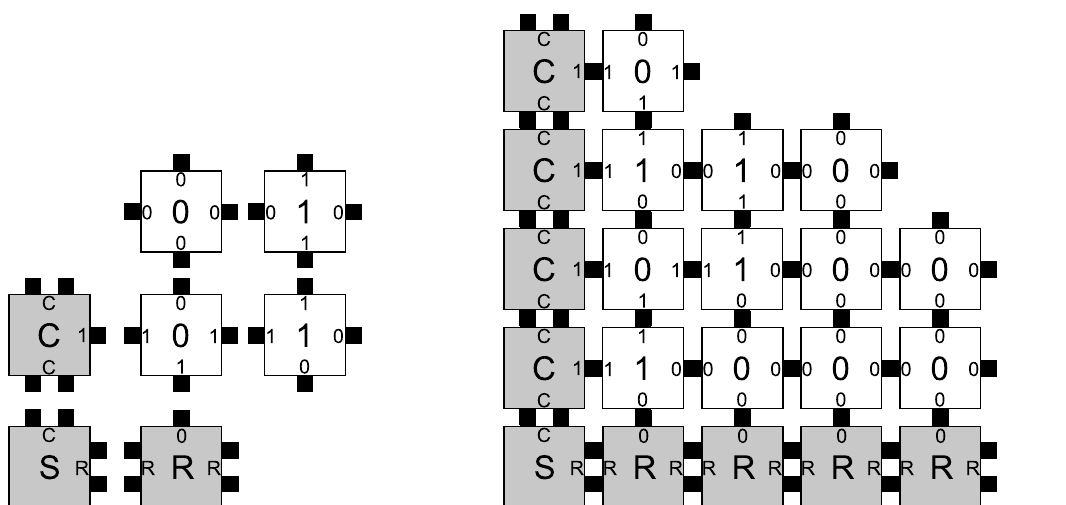
Fig 1. The binary counter tile set (Left) and a partial assembly (Right). The assembler counts from 0, represented as n -bits in the seed, by adding 1 to the previous layer up to the full n -bit value 2 n −